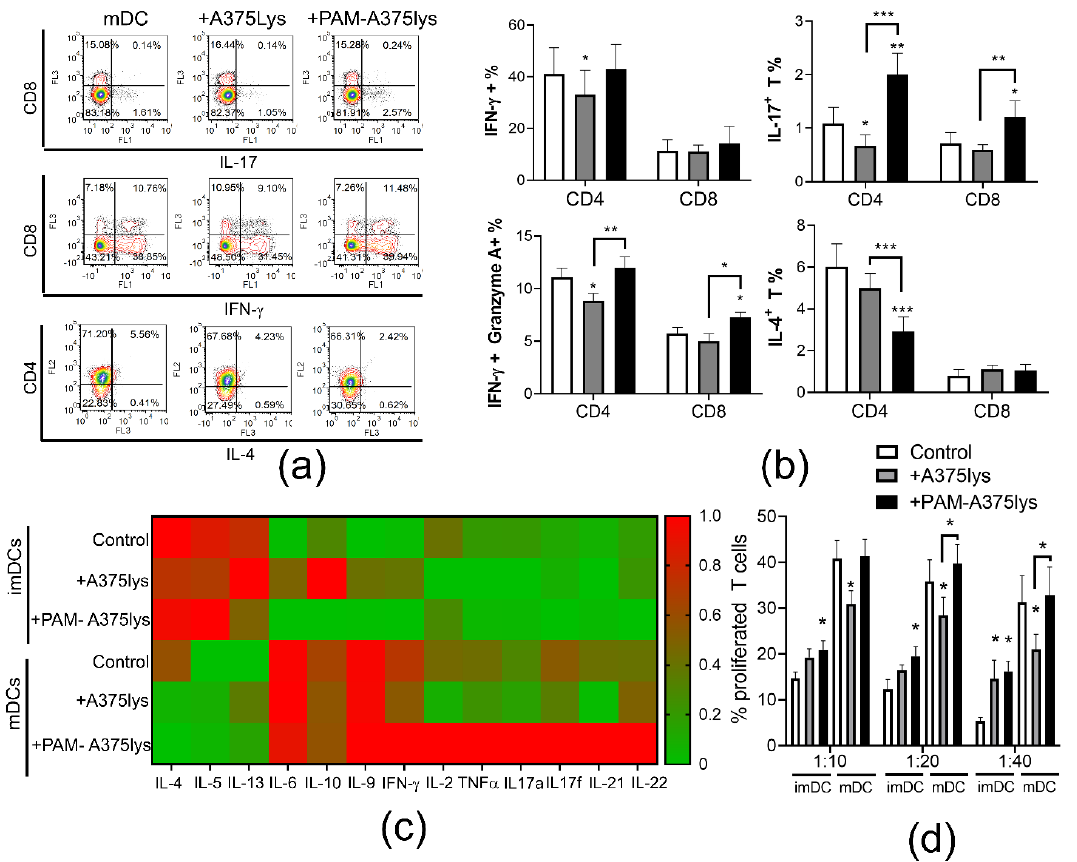
Figure 6. T cell polarization capacity of DCs treated with A375 lysates. ( a ) Immature DCs and mDCs, either treated or not with the A375 lysate (+A375lys) or the PAM-treated A375 lysate (+PAM-A375lys) were co-cultivated with MACS-purified allogeneic T cells (1 × 10 5 /well) at 1:20 (DC: T cell ratio) for 5 days, followed by the stimulation of co-cultures with PMA/Ca Ionophore/monensin for the last 3 h prior to their staining for flow cytometry. Representative dot-plots are shown on the total gated T cells that were co-cultured with the indicated mDCs and afterwards stained to CD4, CD8 and the indicated cytokines. ( b ) The summarized results on the % of cytokine/enzyme expressing cells normalized to 100% of T cells are shown as % ± SD of 3 independent experiments. ( c ) The levels of cytokines from DC/T cell co-cultures as in ( a ), stimulated for the last 3 h with PMA/ Ca ionophore, were measured with the LegendPlex Th13-plex system from the co-culture supernatants. The results are shown as a heatmap wherein each cell represent the level of cytokine normalized in each experiment to the range of 0–1, and averaged from 3 independent experiments, as described in Materials and Methods. ( d ) The allogeneic T cell proliferation was analyzed after 5-day co-cultures of CellTrace Far Red-labeled T cells (1 × 10 5 cell/well) and different number of DC (1 × 10 4 , 0.5 × 10 4 , 0.25 × 10 4 cells/well), providing 1:10–1:40 DC: T cell ratios. The percentage of proliferated (CellTrace Far Red low ) T cells is shown as mean ± SD of 3 independent experiments. * p < 0.05, ** p < 0.01, *** p < 0.005 vs. corresponding control DCs (white bars) or as indicated with lines (RM-ANOVA, Tukey’s multiple comparison test). Statistical significance between the corresponding iDC and mDC was not indicated for